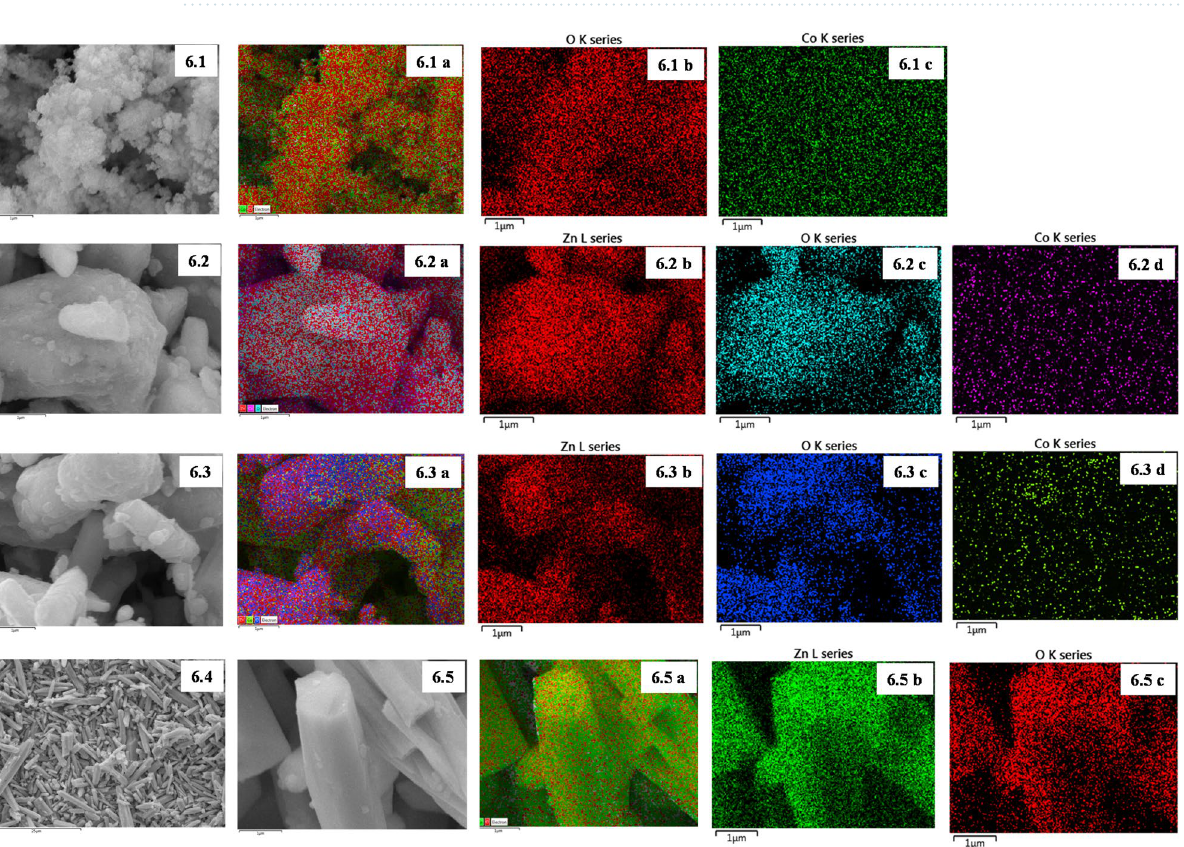
Figure 6. Demonstrates the data of elemental mapping. ( 6.1a , 6.2a , 6.3a , 6.5a ) Merged image of O, Co, and ZnO. ( 6.1b–c , 6.2b–d , 6.3b–d , 6.5b–c ) Elemental mapping images of O, Co, and ZnO elements of Co 3 O 4 NPs, Co 5%, Co 10% and ZnO NRs, Fig. 6.1a–c,6.2a–d,6.3a–d,6.5a–c, we can see the combined mapping of elements. Nevertheless, Fig. 6 consists of individual mappings of the element’s cobalt, oxygen, and zinc.